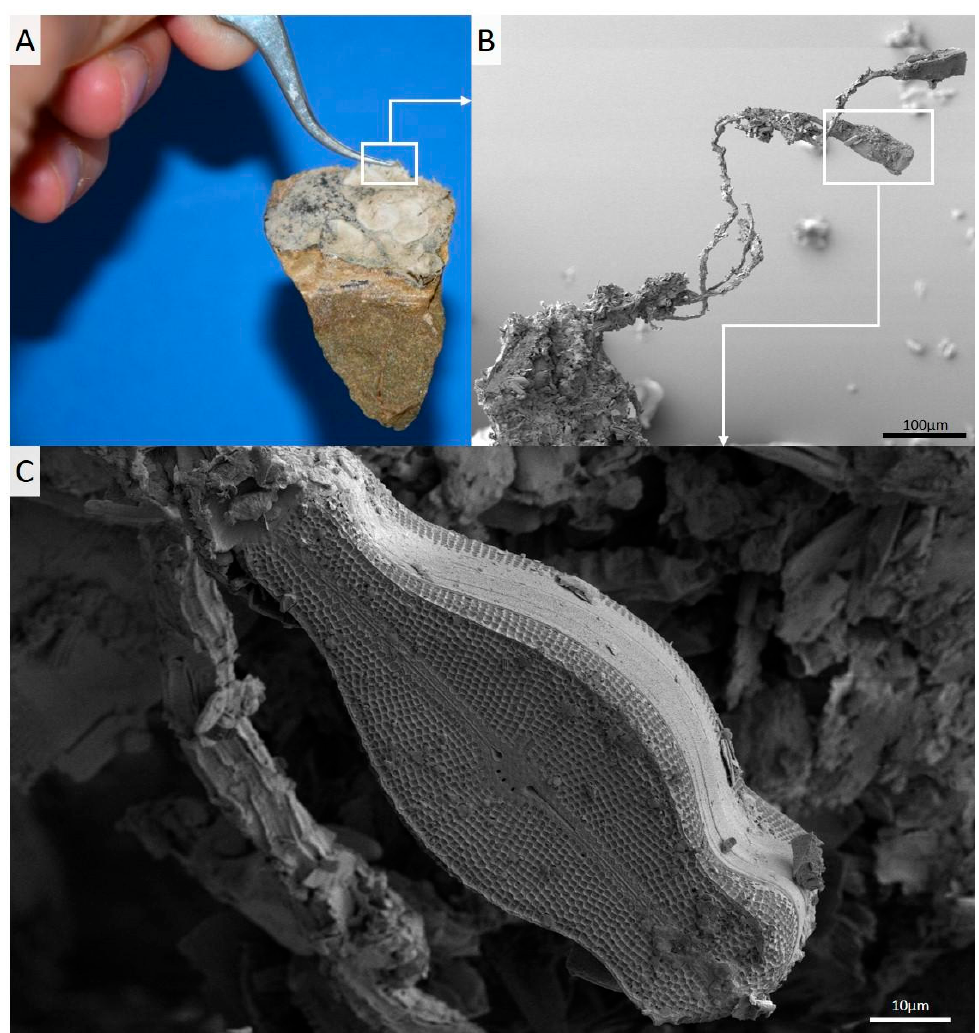
Figure 1. The diatom D. geminata can build stalk-based layers, which are responsible for very strong attachment to the rock surface ( A ). This felt-like layer has so firmly adhered to the surface of a hard substrate that a piece of stone can be held in the air, in a suspended state, without detaching from the ends of the tweezers. SEM images ( B , C ) show that siliceous cells remain attached to biomineralized polysaccharide-containing adhesive stalks.